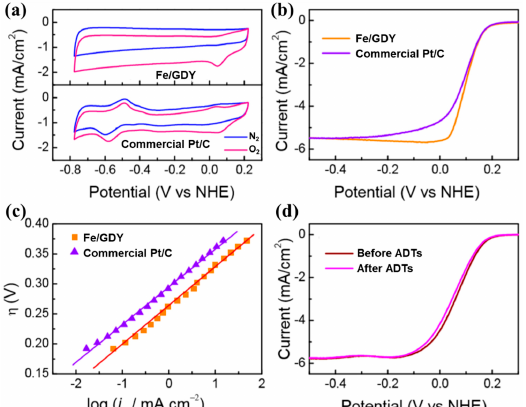
Figure 14. Electrochemical characterizations of Fe / GDY. ( a ) CV responses of the Fe / GDY catalyst and the commercial Pt / C catalyst in N 2 - and O 2 -saturated 0.1-M KOH solution at ambient temperature. The scanning rate was 50 mV / s. The loading of the Fe / GDY catalyst was 0.49 mg / cm 2 , and the loading of the Pt / C catalyst was 20 µ g Pt / cm 2 ; ( b ) RDE measurements in O 2 -saturated 0.1-M KOH solution for the Fe / GDY catalyst and the commercial 20 wt% Pt / C catalyst. The measurements were performed at a rotating speed of 1600 rpm and a scanning rate of 5 mV / s; ( c ) Tafel ORR plots obtained at the Fe / GDY and commercial 20-wt% Pt / C catalyst; ( d ) stability of the Fe / GDY catalyst to the ORR. The RDE responses were recorded in O 2 –saturated 0.1-M KOH solution at a rotating speed of 1600 rpm and a scanning rate of 5 mV / s before and after ADTs (reproduced with permission from [135]. Copyright